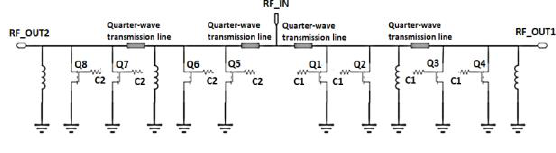
Figure 21: Schematic of the switch